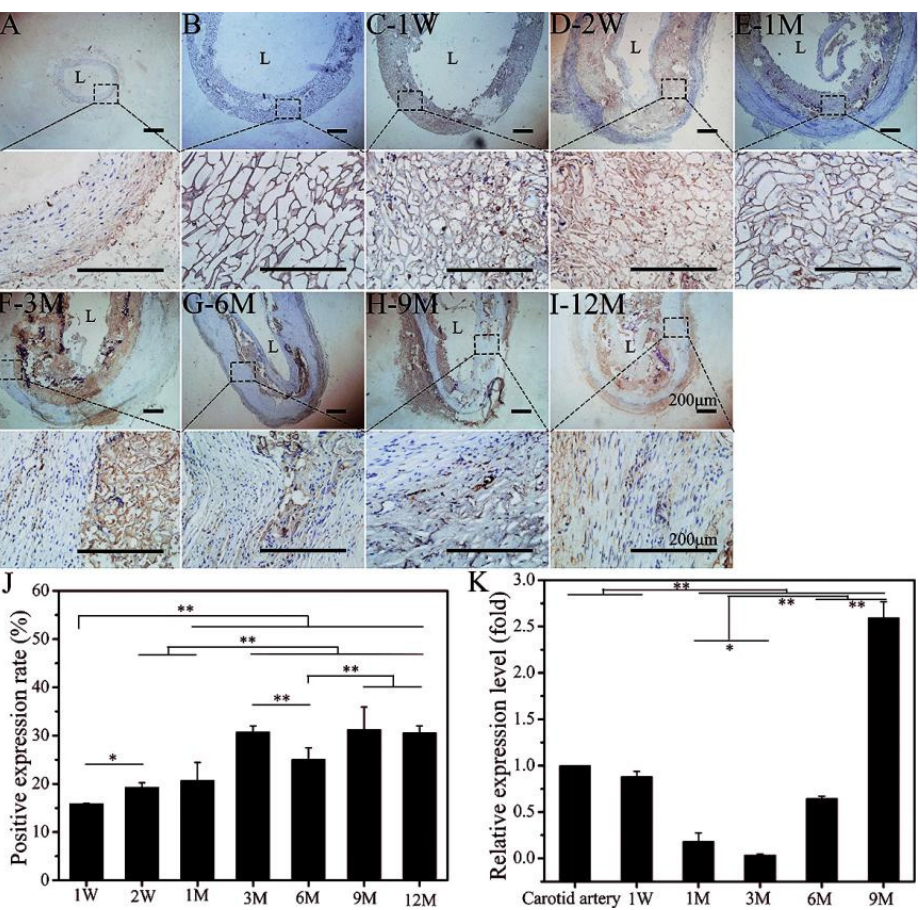
Figure 8. Immunoenzyme staining of LOXL-1. ( A ): Autogenous carotid artery; ( B ): non-implanted SFTS; ( C – I ): different time points after implantation; ( J ): semi-quantitative results of positive expression rates; ( K ): mRNA expression level of LOXL-1. Data are presented as mean ± SD, n = 3. The scale bar is 200 μ m. “*” represents p < 0.05; “**” represents p < 0.01.